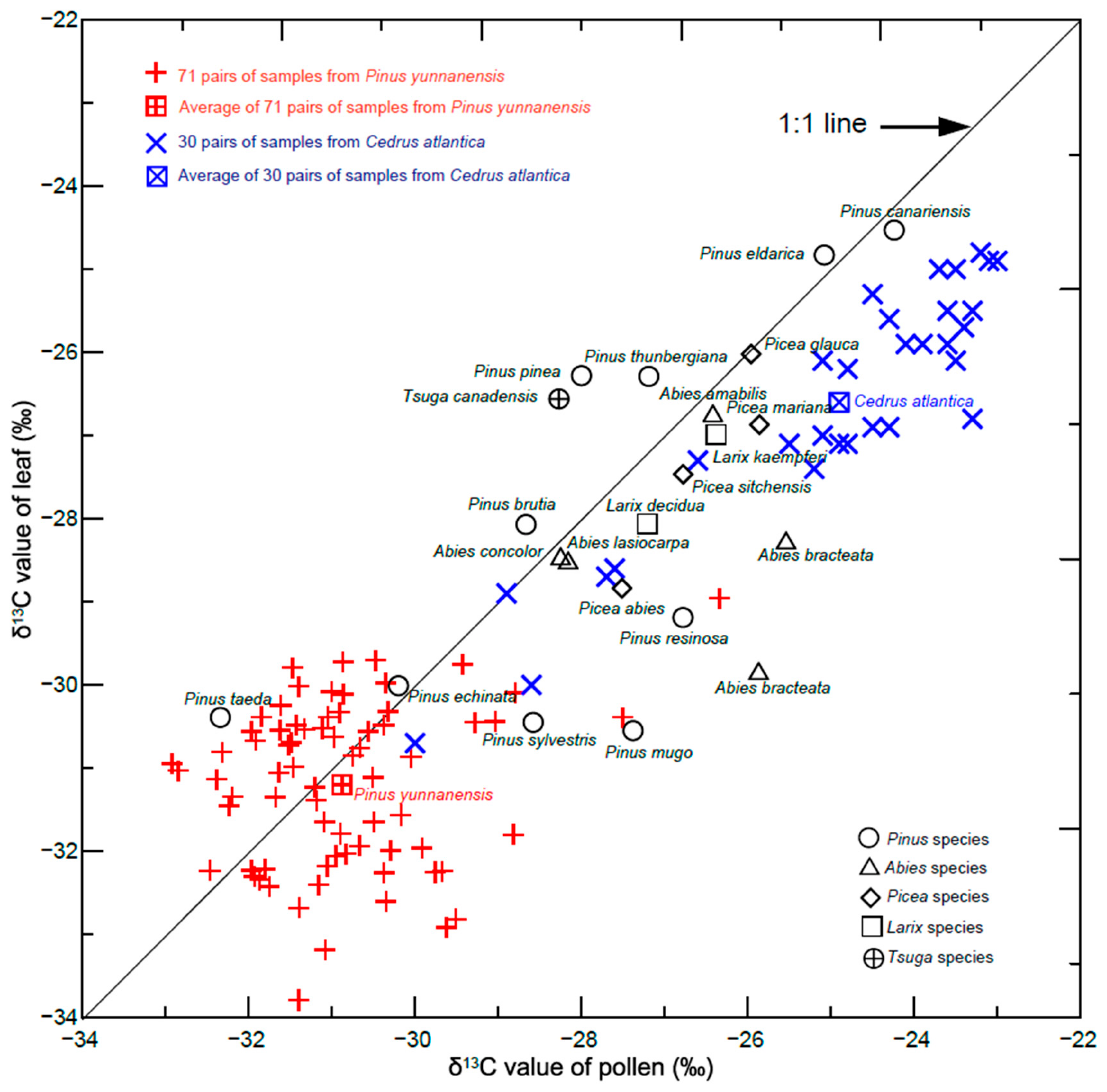
Figure 5. A comparison of pollen and leaf δ 13 C values from Pinus yunnanensis with available data from Pinaceae species [35,36].